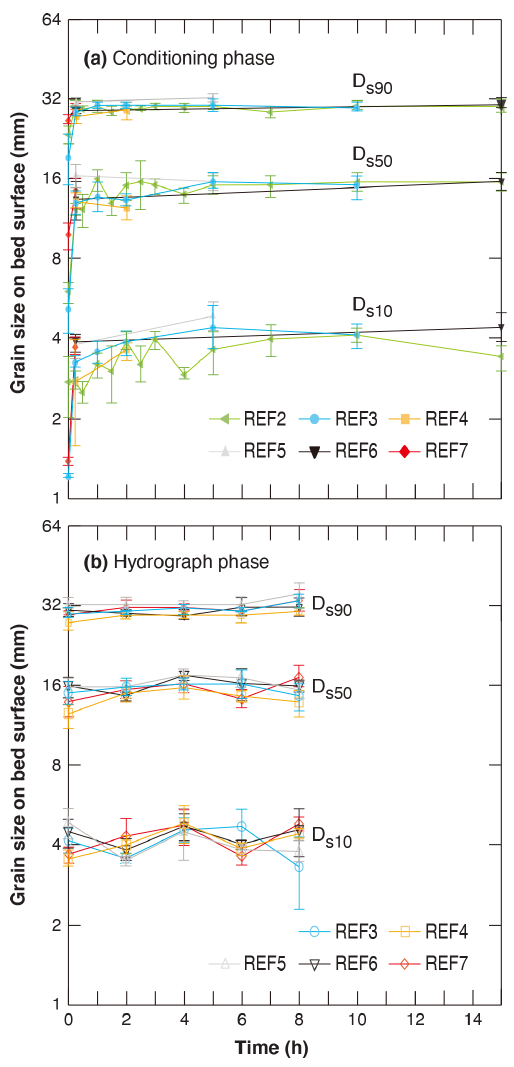
Figure 5. Temporal adjustments of characteristic grain sizes of bed surface material calculated over the whole erodible bed: (a) the con- ditioning phase and (b) the hydrograph phase. Markers show mean values of five repeated Wolman measurements. Range bars show the mean values ± the standard deviations of the five repeated Wolman